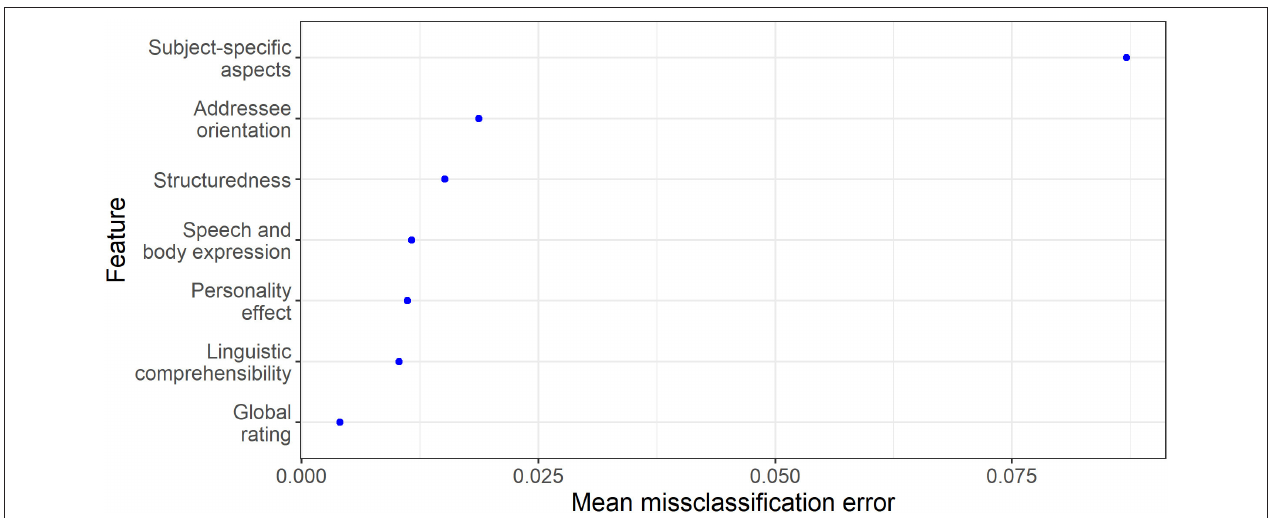
FIGURE 5 | Feature importance plot regarding the prediction of school subject membership by the six constructs and the global rating operationalized in